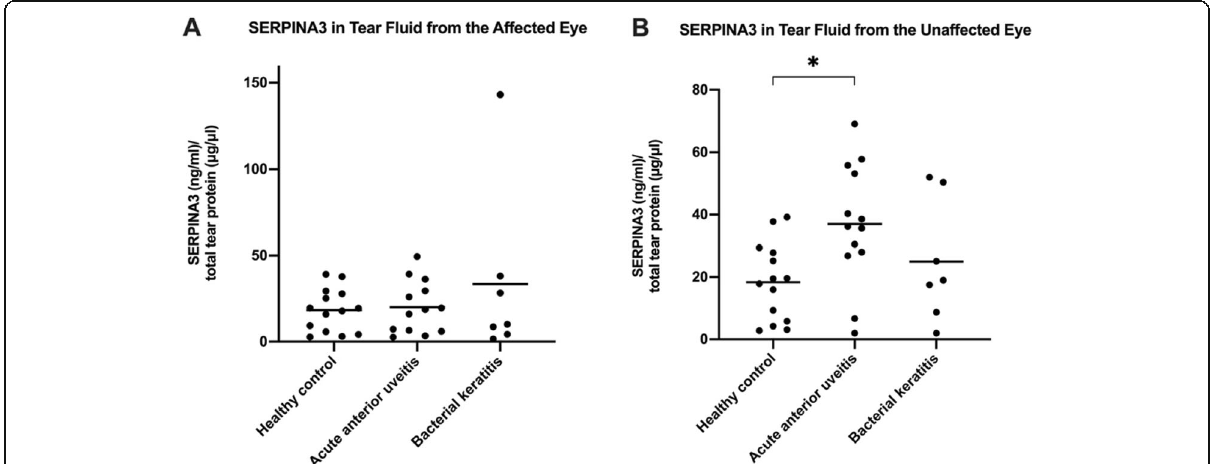
Fig. 2 Serpin Family A Member 3 (SERPINA3) was measured in tear fluid of the affected eye ( A ) and unaffected eye ( B ) by enzyme-linked immunosorbent assay in patients with unilateral acute anterior uveitis and bacterial keratitis and in healthy controls. Individual patient values are plotted together with mean values (horizontal lines). * P = 0.019